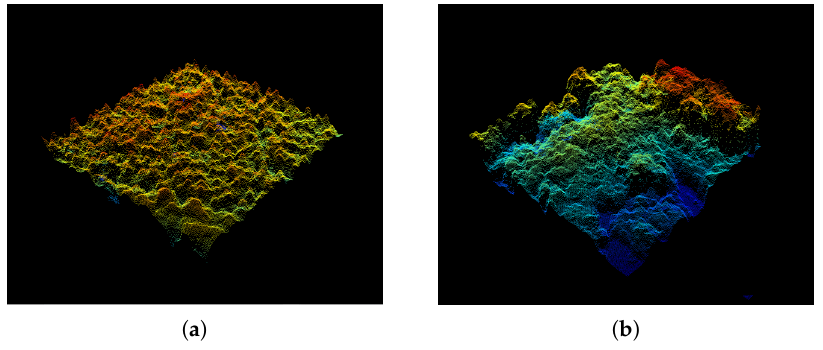
Figure A1. Visual representation of the “Height Variation Hypothesis”: the subfigure ( a ) shows the LiDAR point cloud over a forest plot (1 ha) having a low height heterogeneity and a low species diversity. On the other side, plot ( b ) shows a higher height heterogeneity and a related higher species diversity.